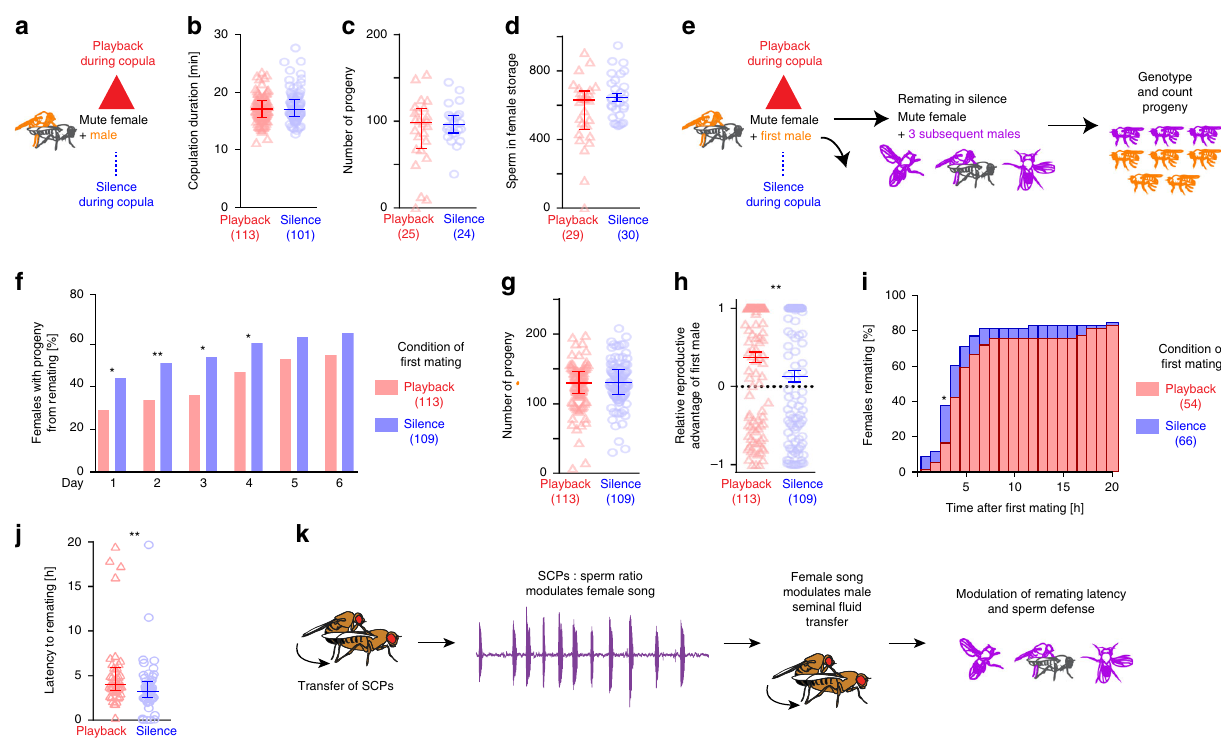
Fig. 4 Female copulation song decreases remating. a Experimental design for testing the effect of female song. Data from the playback condition is shown in red, from the control silence condition in blue. b Copulation duration of mute females with wild type males, with and without female song playback. c Adult progeny after 6 days of egg laying from copulations of mute females with wild type males, with and without female song playback. d Number of sperm in female storage organs after copulations with and without female song playback. e Experimental design for testing the effect of female song playback under subsequent reproductive competition. The fi rst male and it ’ s progeny is displayed in orange, the subsequent males and their progeny in magenta. f Female remating after copulations with and without song playback. * p = 0.0258 (day 1), ** p = 0.0097 (day 2), * p = 0.0102 (day 3), * p = 0.0446 (day 4). Fisher ’ s exact test (two-sided). g Adult progeny after 6 days of egg laying, from copulations of mute females with wild type males, with and without female song playback, with the female subsequently housed with 3 males carrying genetic markers Sb/ Tm3, Ser . h Relative reproductive advantage of the fi rst male ((progeny fi rst male − progeny subsequent males)/all progeny)) in the experiment outlined in e after 6 days of egg laying. n is indicated after the conditions, error bars indicate standard error of the mean, ** p = 0.0099, permutation testing (one-sided). i Percentage of wild type females muted by wing amputation remating within 20 h with wild type males after copulations with and without song playback. * p = 0.014, Fisher ’ s exact test (two-sided). j Latency to the fi rst remating after copulations with and without song playback. ** p = 0.0035, Mann-Whitney test